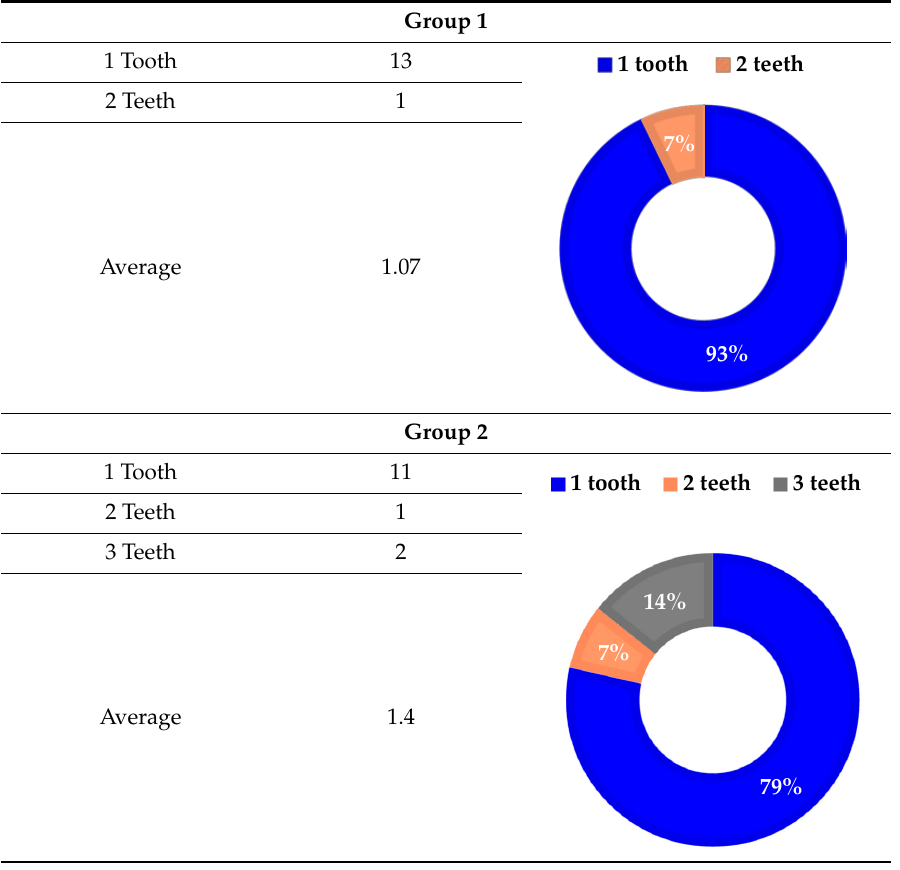
Table 3. Tooth analysis type and site.